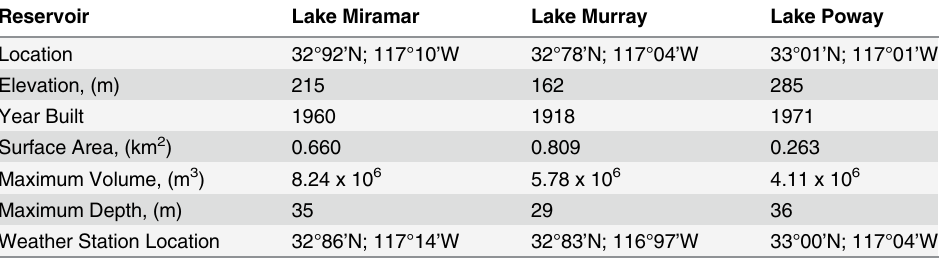
Table 1. Characteristics of three reservoirs sampled weekly from 26 June 2013 – 26 June